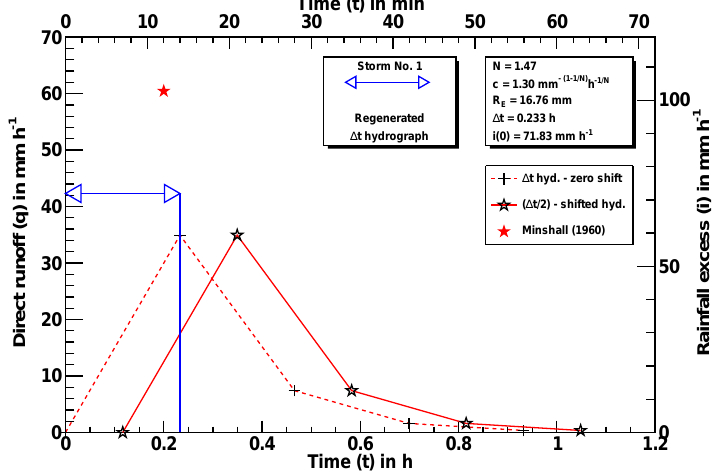
Fig. 5b. Same as Fig. 5b, except the 1t hydrograph is computed by the inverse Bakhmeteff function method of